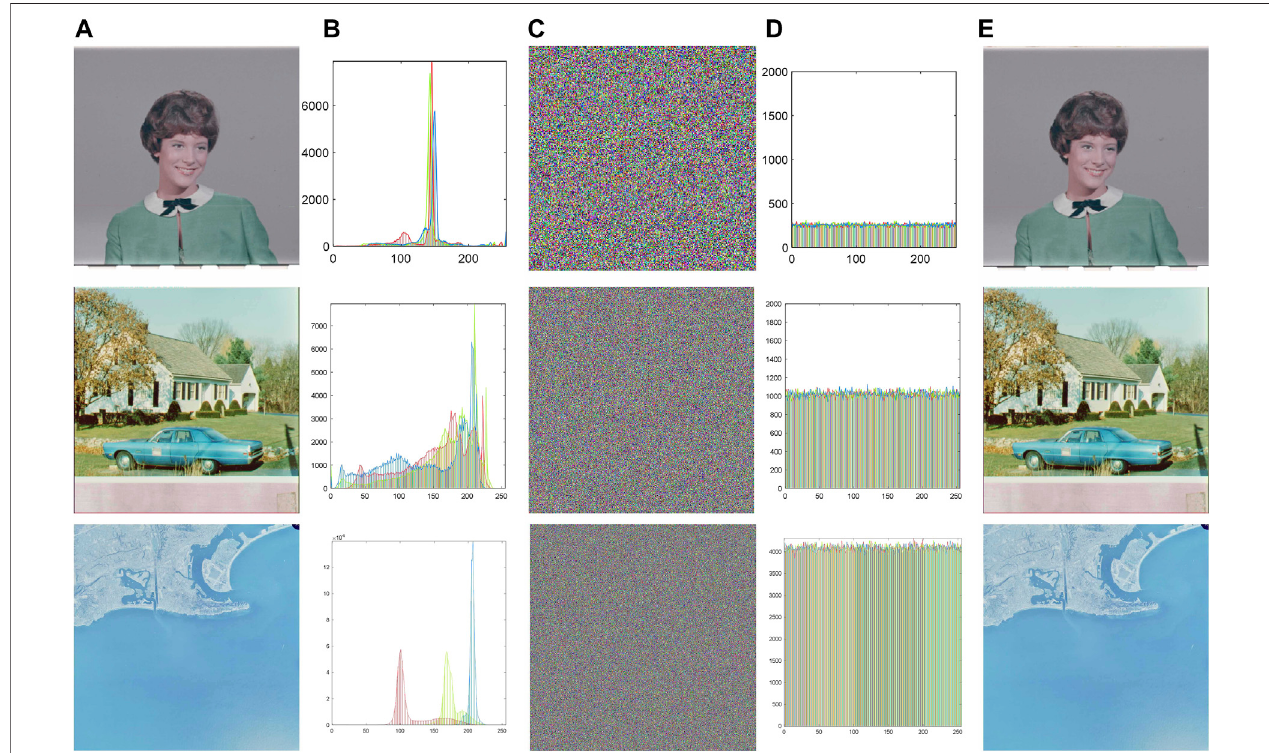
FIGURE 4 | Color image [43] simulation results: (A) plain images, (B) histograms for (A) , (C) encrypted images, (D) histograms for (B) , and (E) decrypted images.